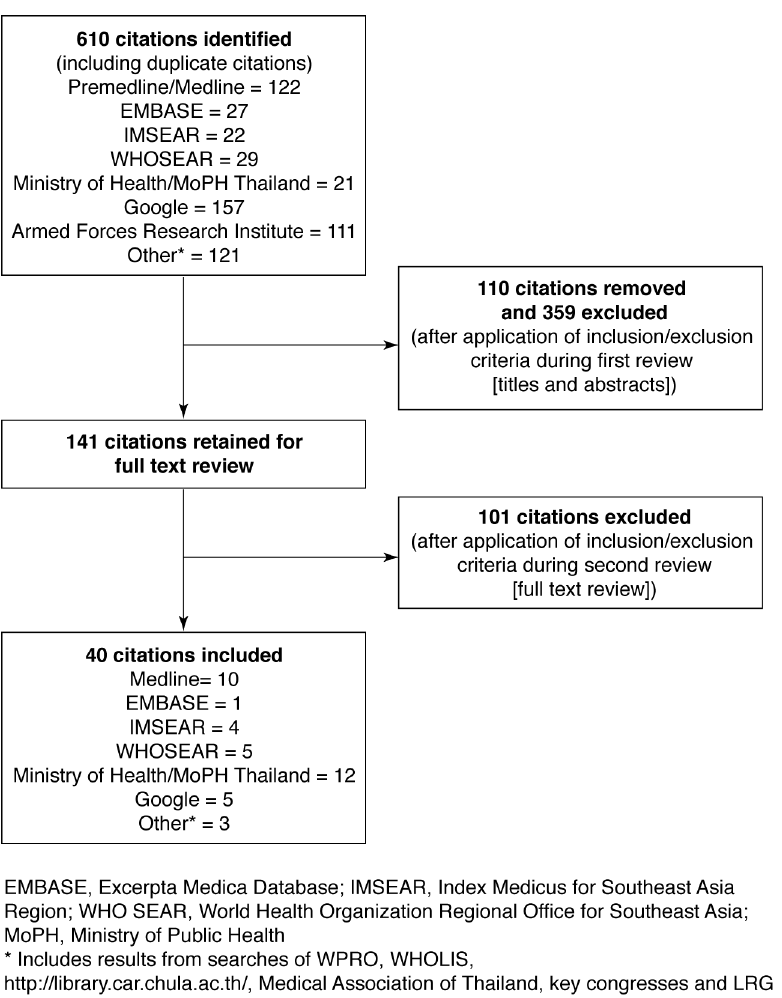
Figure 1. Results of literature search and evaluation of identified data sources according PRISMA. Duplicates and articles that did not satisfy the inclusion criteria were removed following evaluation of the titles and abstracts. The full text of these documents was examined to facilitate the final selection of relevant articles. Included publications were collated and summarized using a data extraction instrument developed as a series of spreadsheets, as described in the